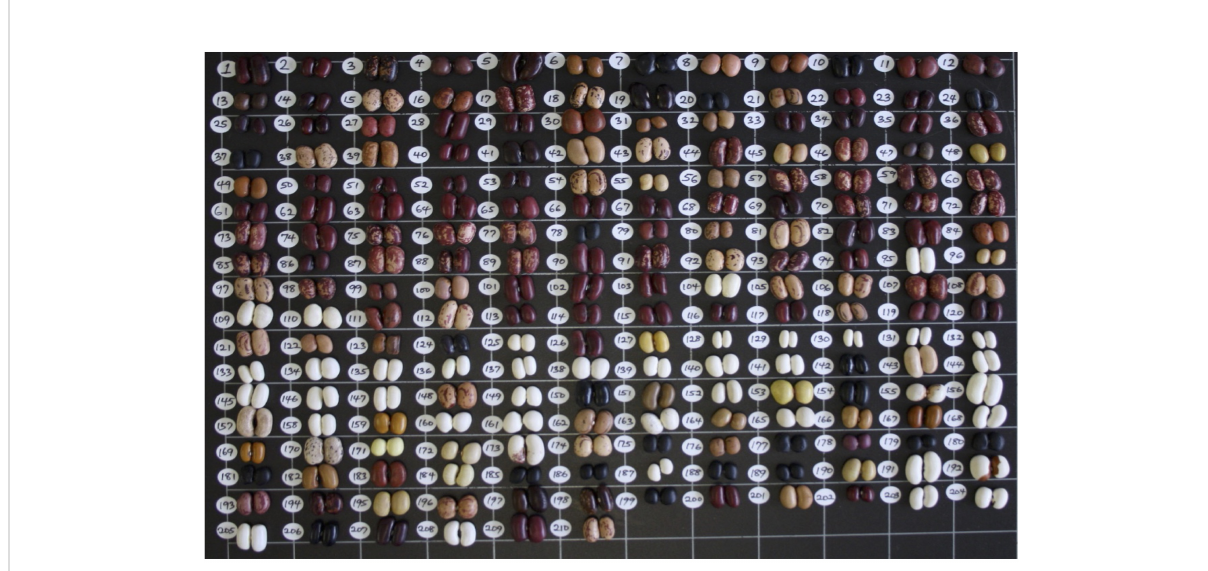
FIGURE 1 Phenotypic diversity of common bean seeds observed within the panel. Numbers correspond to genotype names in Supplementary Table